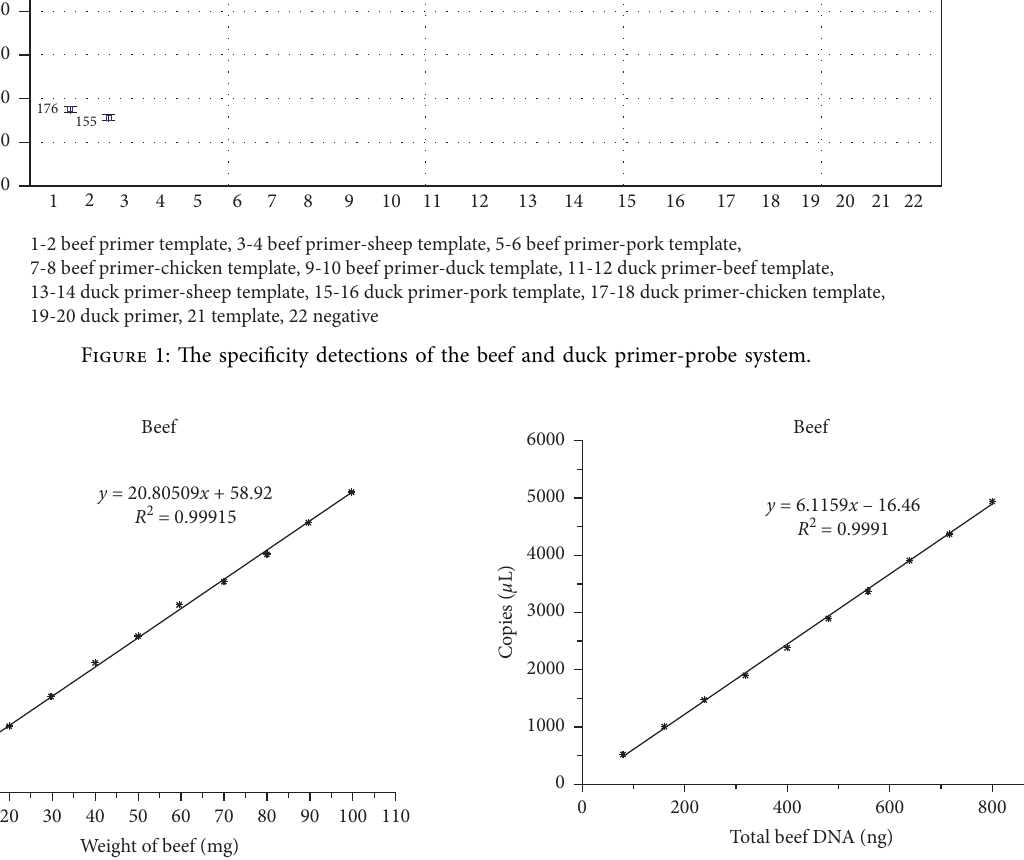
Figure 2: The relationship between the quality of raw meat and the DNA content of beef samples.